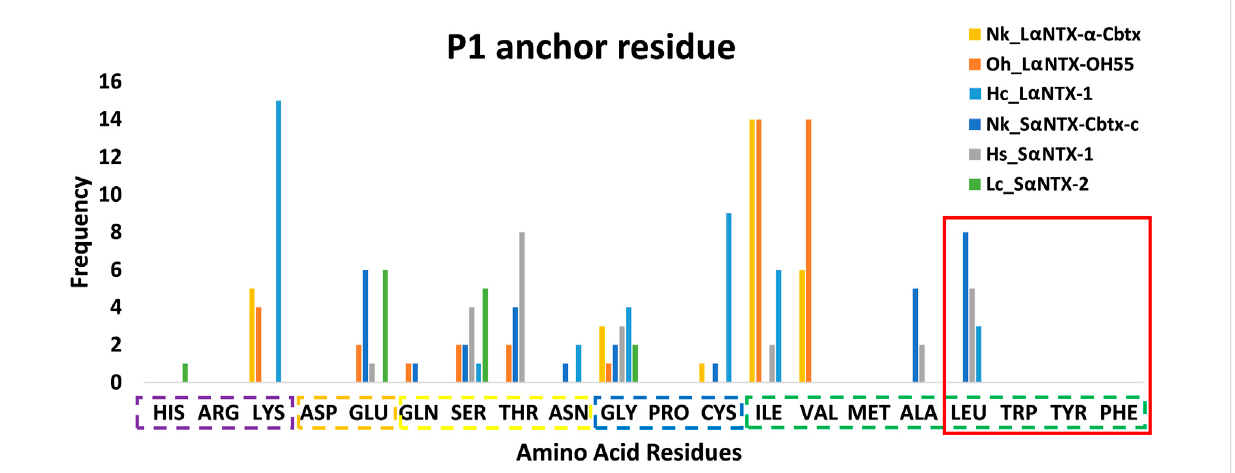
FIGURE 6 Anchor residue preferences of P1 pocket. Violet box: Positive side chain; Orange box: Negative side chain; Yellow box: Polar side chain; Blue box: Special cases; Green box: Non-polar side chain; Red square: Optimal P1 anchor residues. Abbreviations: Nk_L α NTX- α -Cbtx, α -cobratoxin (UniProt ID: P01391, N.kaouthia );Oh_L α NTX-OH55,long neurotoxin OH55 (UniProt ID:Q53B58, O. hannah );Hc_L α NTX-1,longneurotoxin1 (UniProt ID:Q8UW29, H. curtus ); Nk_S α NTX-Cbtx-c, cobrotoxin-c (UniProt: P59276, N. kaouthia ); Hs_S α NTX-1, short neurotoxin 1 (UniProt ID: P68415, H. schistosus ); and Lc_S α NTX-2, short neurotoxin 2 (UniProt ID: P10457, L. colubrina